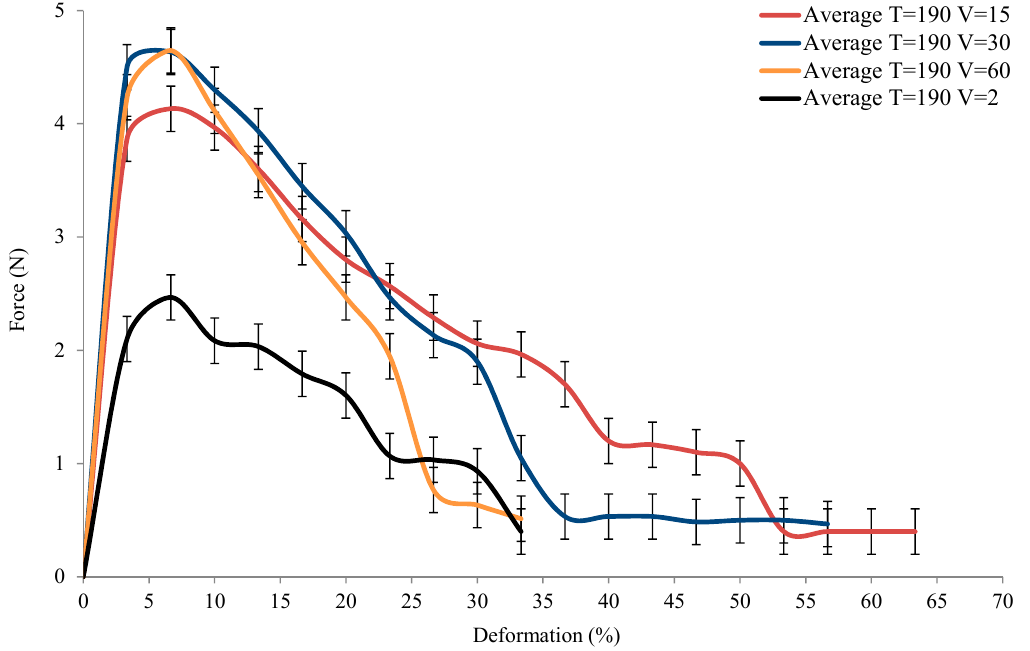
Figure 7. Load vs. deformation under variation of tested speed.